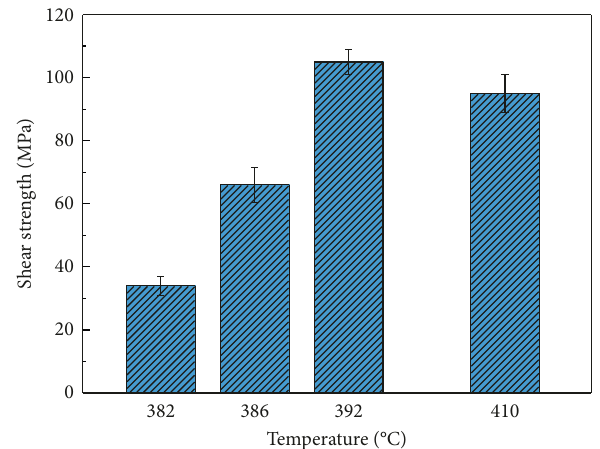
Figure 10: Relationship of shear strength of the joint with the brazing temperature.